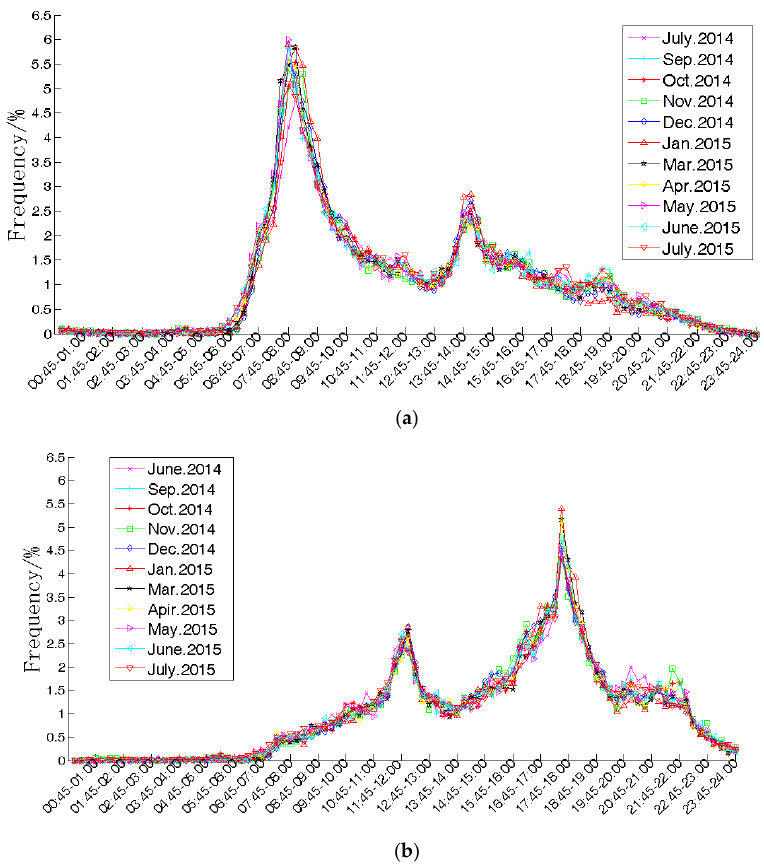
Figure 6. Arrival time and departure time distribution: ( a ) arrival time; and ( b ) departure time.